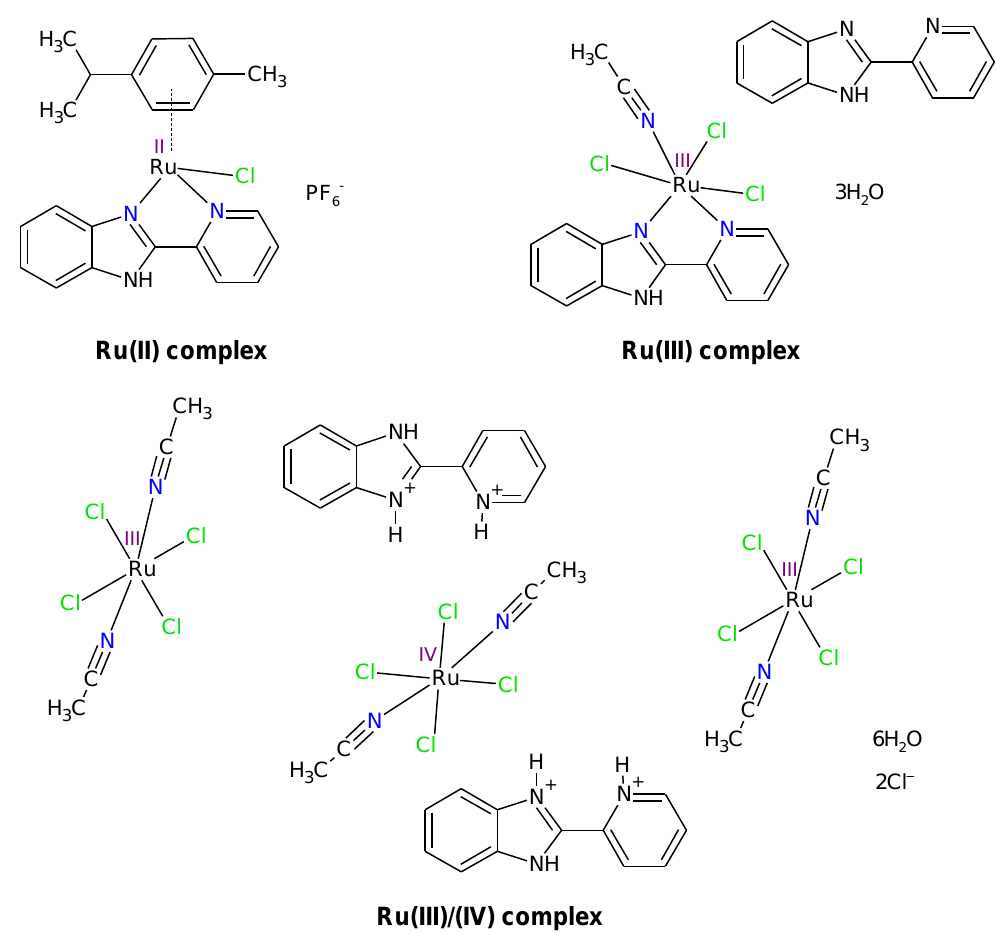
Figure 1. The structures of the ruthenium complexes in different oxidation states with 2-pyridin-2-yl-1H-benzimidazole.